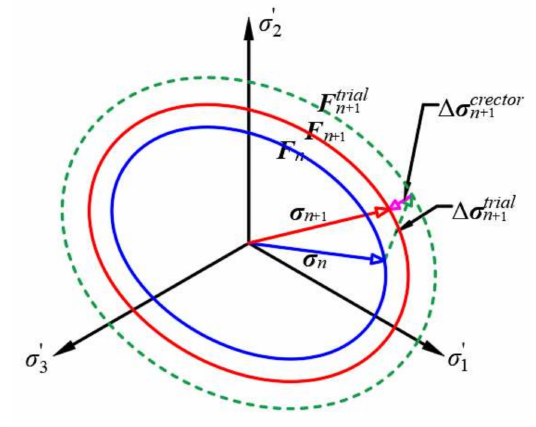
Figure 6. Schematic diagram of stress return mapping